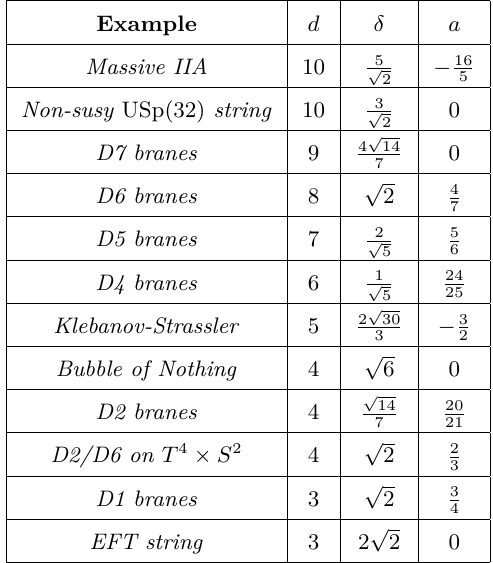
Table 1 . Table of examples in this paper, with the corresponding parameters for the local description near the ETW